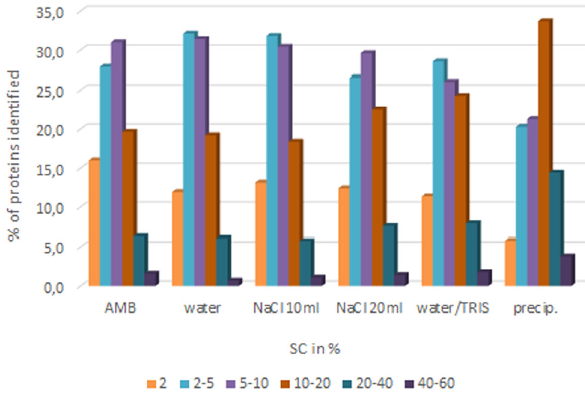
Figure 2: SC distribution of proteins identi fi ed from 10 mL of urine ( except NaCl 20 mL ) by various isolation methods: